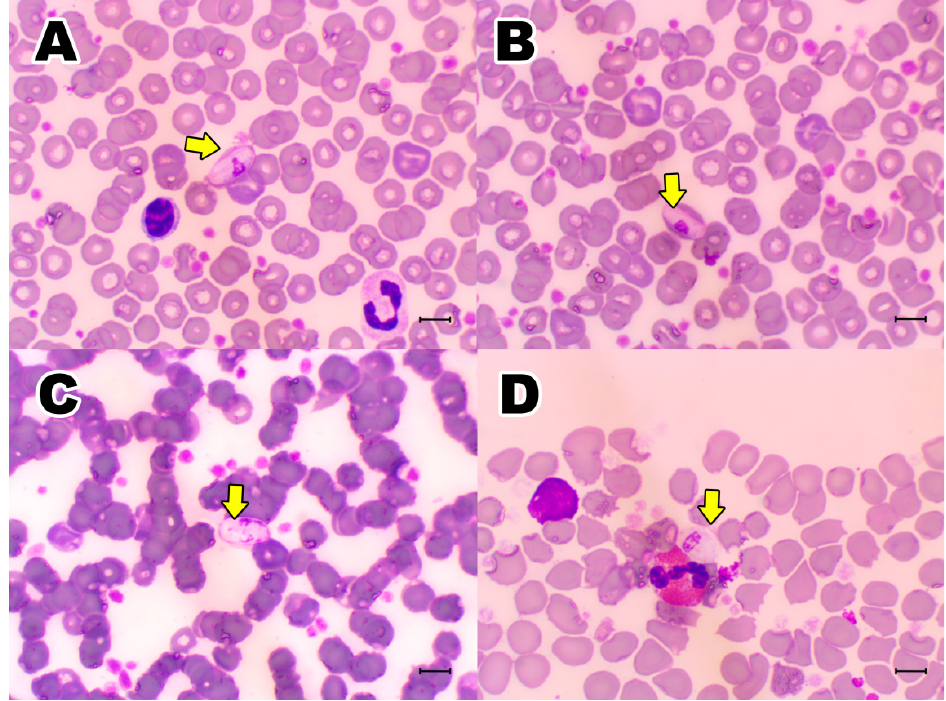
Figure 4. Light microscopy image of Romanowsky-type-stained peripheral blood smear from black-eared opossum ( Didelphis aurita ), showing ( A , B ) intra-erythrocyte Hepatozoon sp. gamonts (arrow), and ( C , D ) free (between cells). Sample from female adult ( A , B , D ) and a male adult ( C ) black-eared opossum (1000× magnification). Bar = 10 μ m.